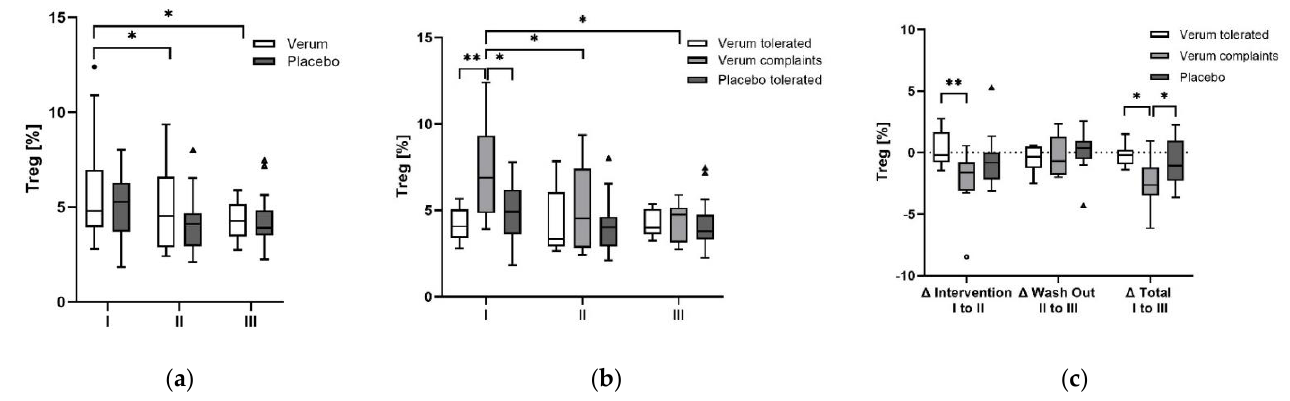
Figure 3. Progression of regulatory T-cell frequencies. ( a ) Treg frequencies decreased in V over the course of the study whilst Tregs in P remained almost constant. ( b ) When separated for tolerability groups Vc had significantly higher Treg % at baseline compared to Vt and P. Treg values decreased in Vc continuously during the study. ( c ) Tregs remained almost stable in Vt and P whilst a significant reduction in Treg % was observed for Vc. p -values < 0.05 are marked with *, < 0.01 with **, and < 0.001. Outlayers of V and Vt are highlighted as black circles, of Vc as circles, and of P as black triangles.